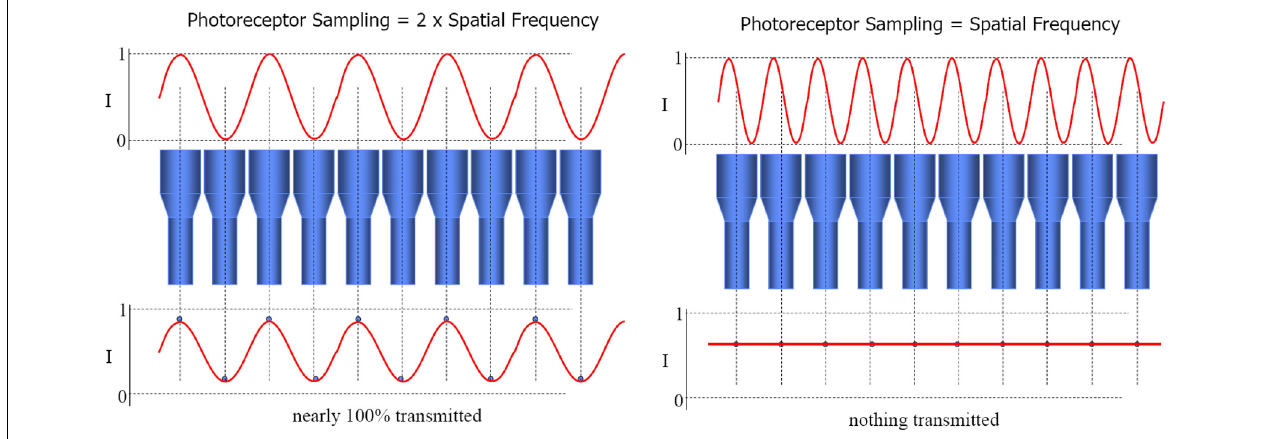
FIGURE 2 | The loss of the sinusoidal signal when signal frequency equals sensor distribution frequency constitutes morphological resonance. Constructive interference, and hence